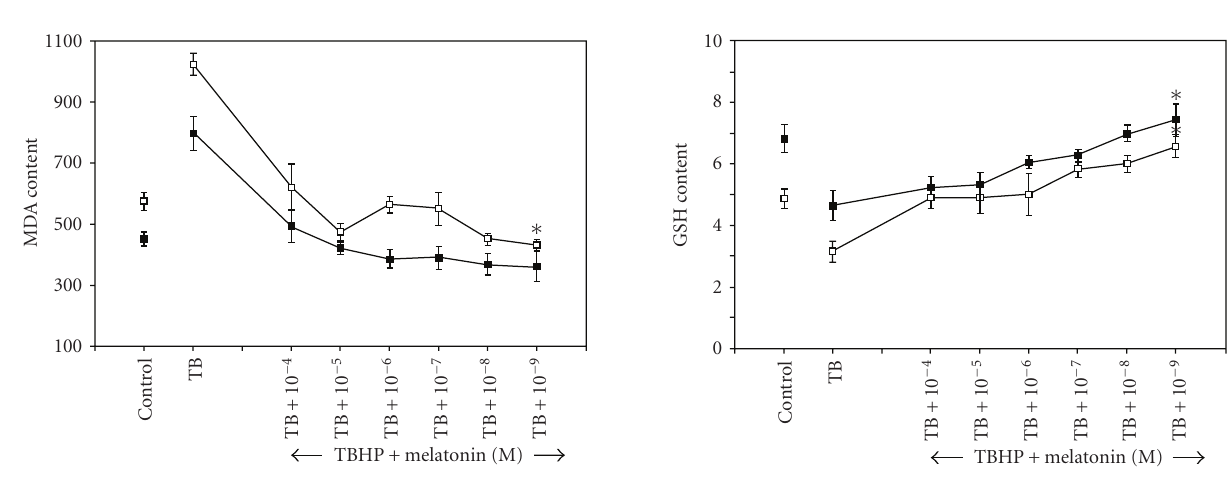
Figure 2: Day and night variation in malondialdehyde content in red blood cells after in vitro treatment with melatonin. The points ( (cid:2) ) and ( (cid:3) ) represent the e ff ect of melatonin in diurnal and nocturnal blood samples, respectively. Significant variation was observed in diurnal-treated samples ( ∗ P < . 05), the response being pronounced at nanomolar doses. MDA content is expressed as nanomoles per millilitres of packed RBCs.